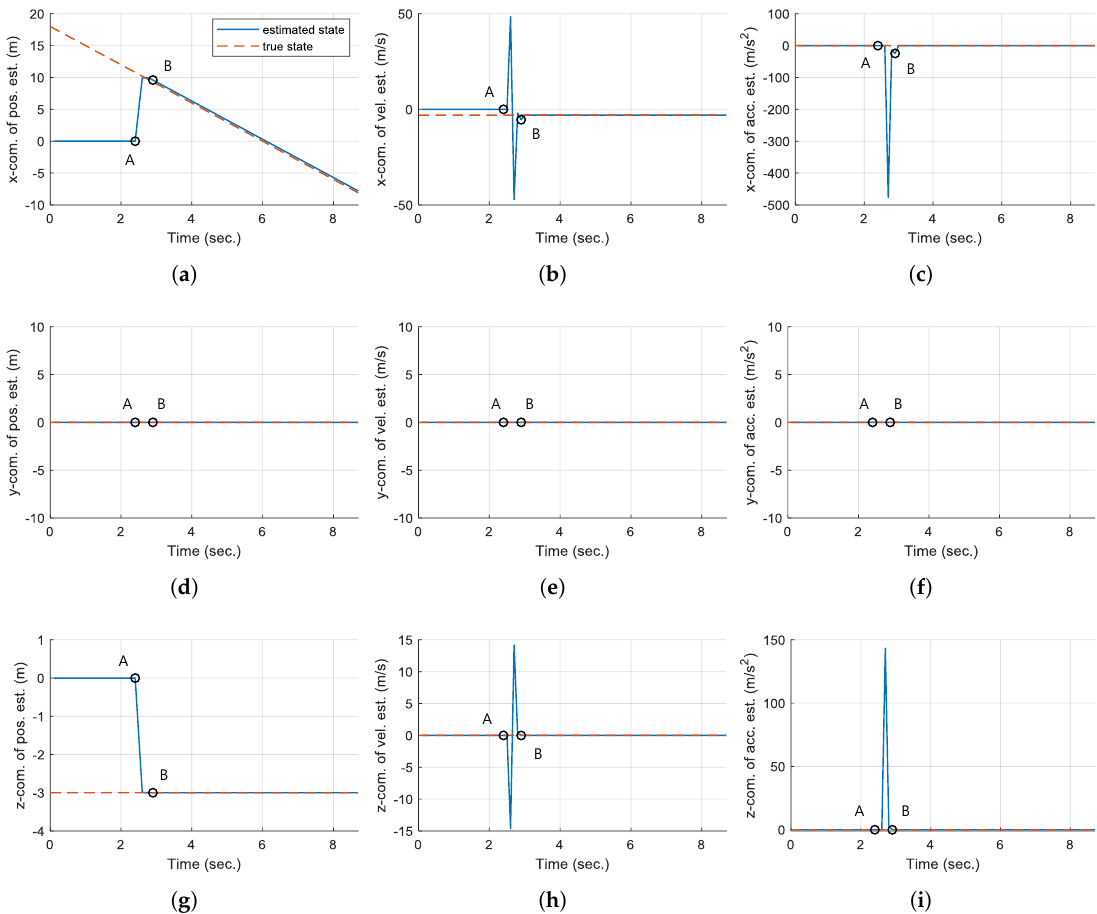
Figure 8. Time histories of the state estimate (Simulation I): ( a ) x n ( f ) ¨ y n , ( g ) z n , ( h ) ˙ z n , and ( i ) ¨ z n e , k e , k e , k